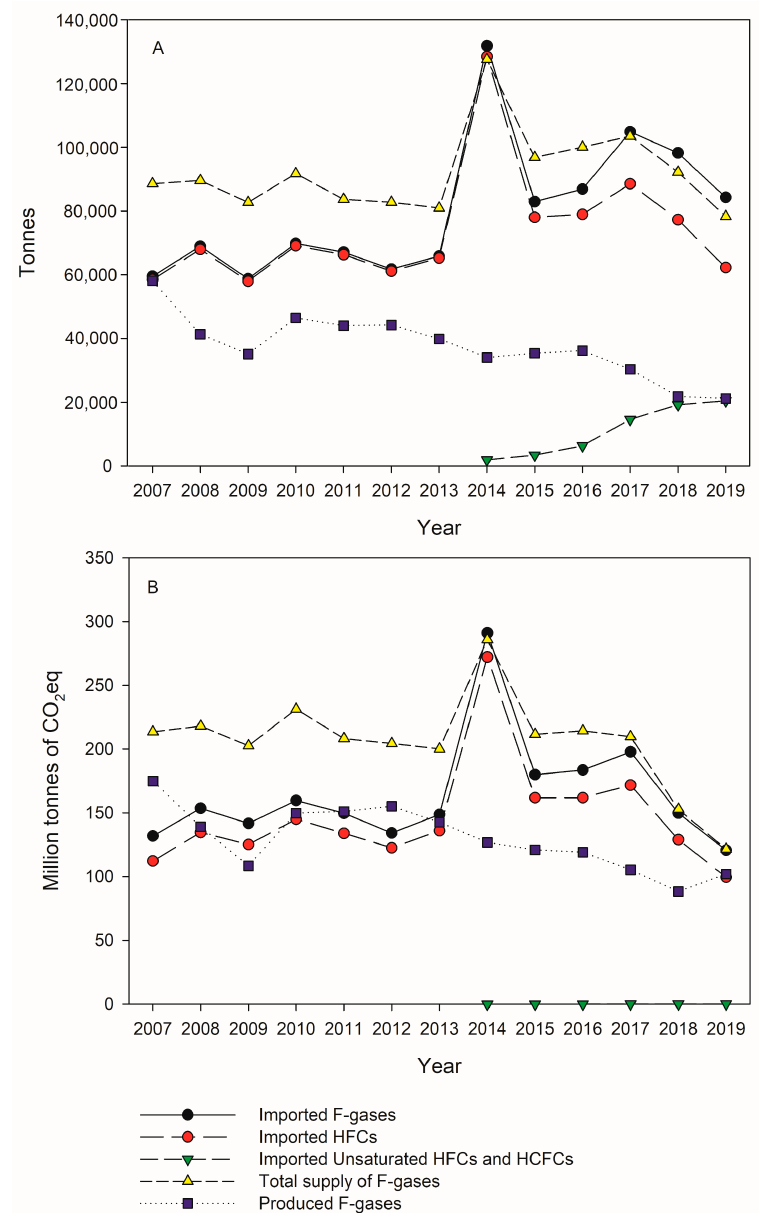
Figure 1. Imports, production and total supply of F-gases and imports of HFCs and of unsaturated HFCs and HCFCs in the EU (2007–2019) according to the EEA Report No 15/2020 on